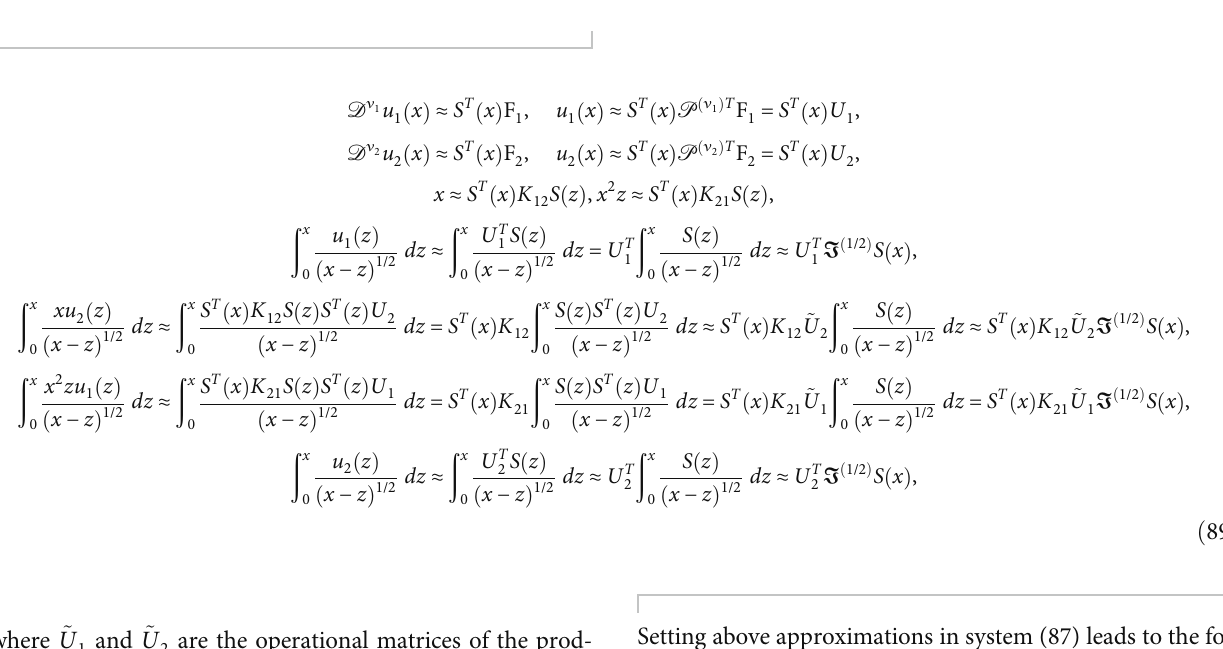
= ν = 1 of Example 1 2